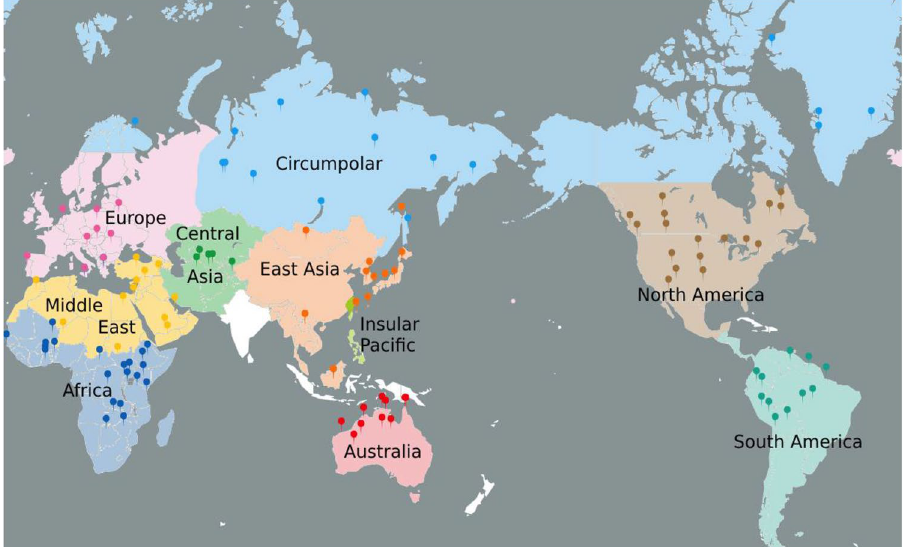
Figure 1. A geographic map of the song sampling according to the 10 major musical-style regions of the world, as color-coded by region. The 418 samples are distributed across style-regions as follows: Africa, 41 songs; Australia, 17; Central Asia, 16; Circumpolar region, 52; East Asia, 50; Europe, 51; Insular Pacific, 52; Middle East-North Africa, 38; North America, 50; South America, 51. The map was made in ArcGIS with further editing in